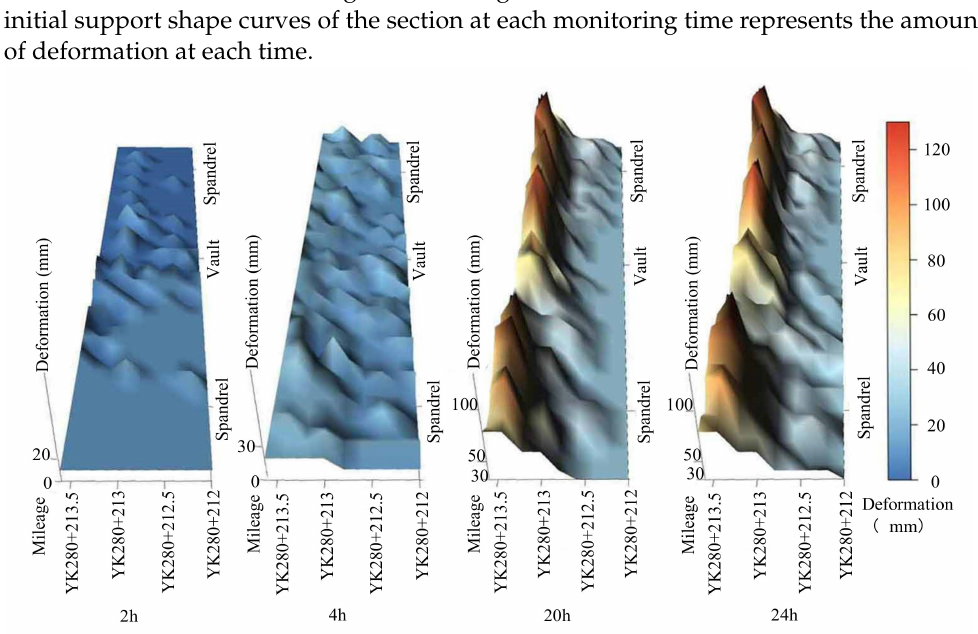
Figure 11. Three-dimensional deformation map of the upper step of the tunnel.